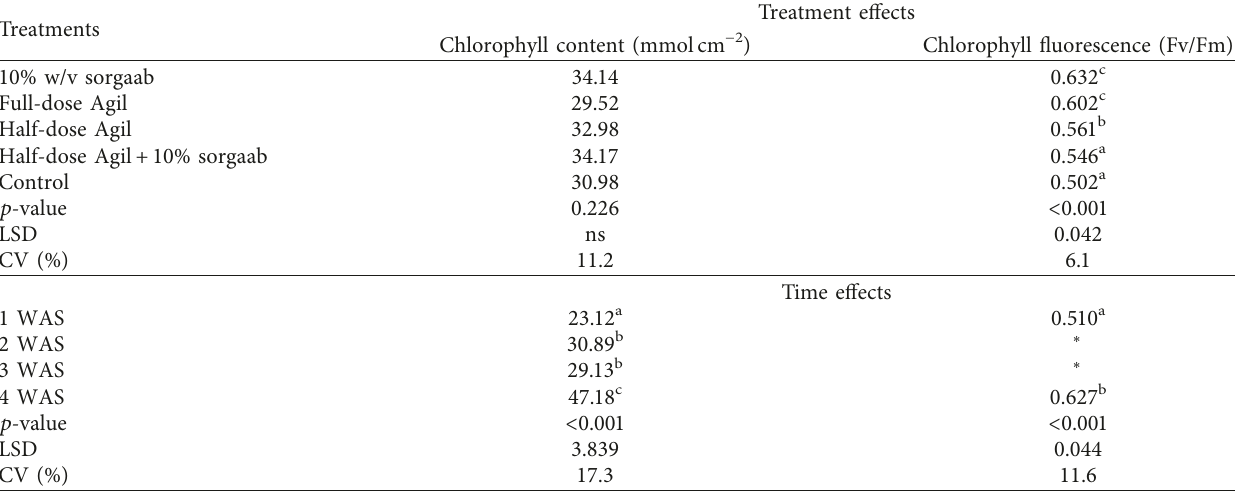
Table 6: Effect of different bioherbicidal treatments on the chlorophyll content and chlorophyll fluorescence of black jack. Treatments